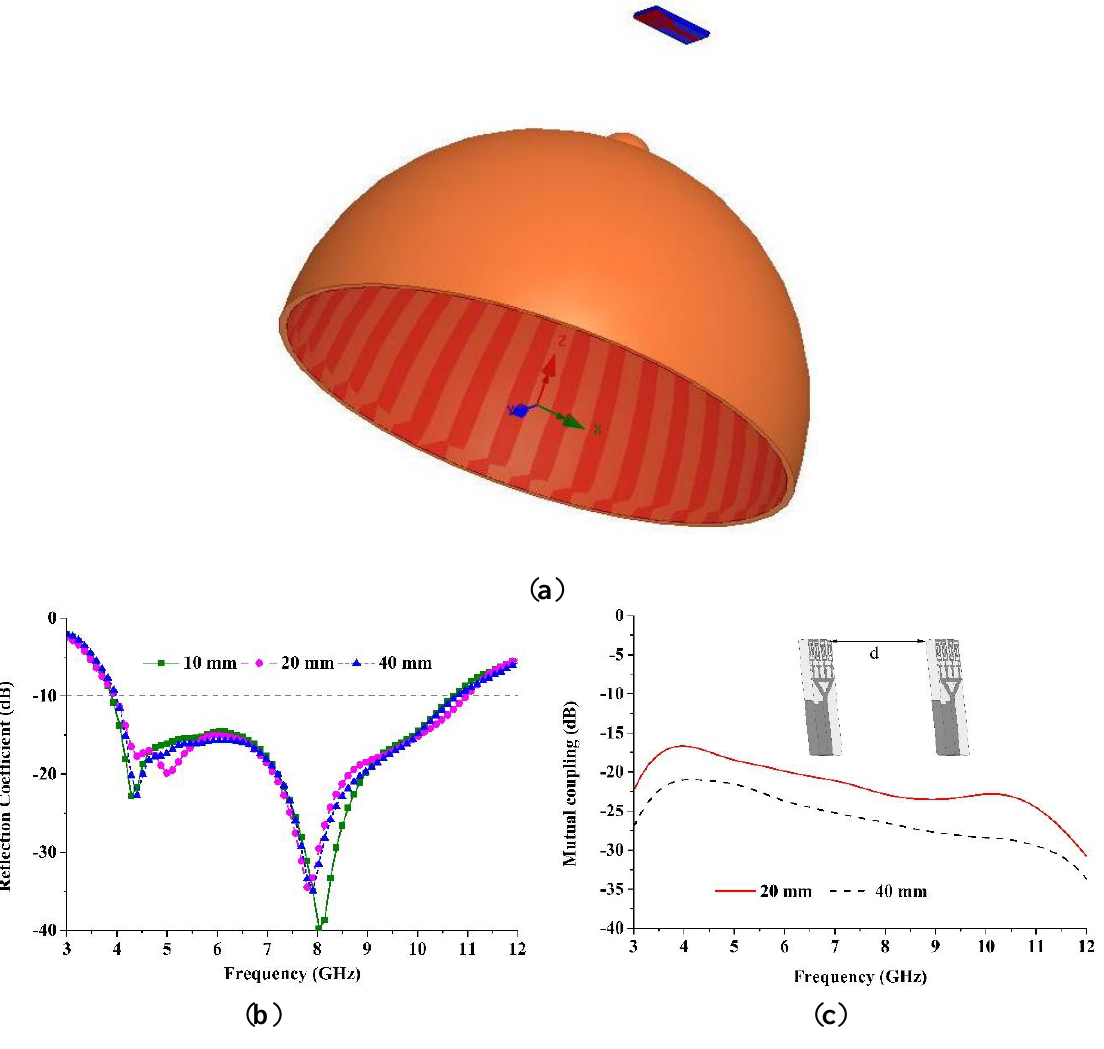
Figure 12. ( a ) Simulation model depicting the breast and the proposed metamaterial antenna; ( b ) reflection coefficient variation with frequency from the breast at various distances; ( c ) mutual coupling variation between two similar antennas with respect to frequency at two different